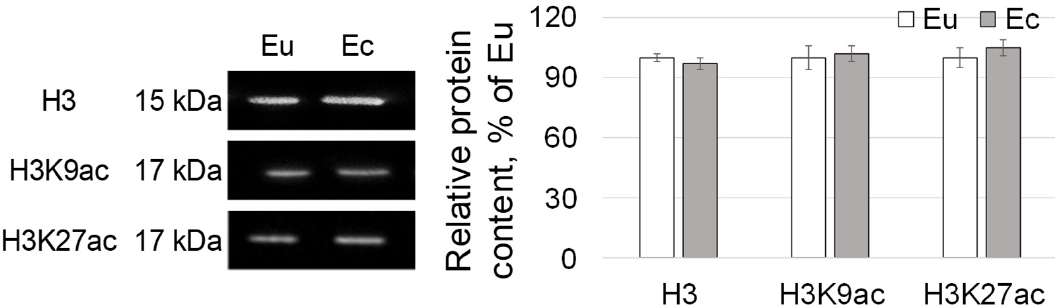
Figure 3. The relative protein content of the histone H3 and its acetylated modifications with West- ern-blots in the eutopic and ectopic endometrium. Eu—eutopic endometrium. Ec—ectopic endome- trium. H3—histone H3. H3K9ac—histone H3 acetylLys10. H3K27ac—histone H3 acetylLys28. West- ern-blotting for H3 and H3K9ac was performed twice, for H3K27ac—thrice.